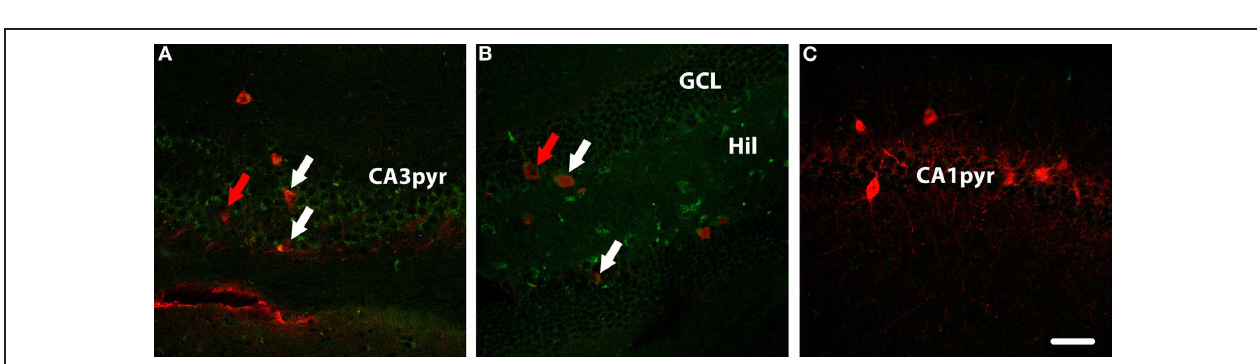
FIGURE 4 | GAD-67 (red) and WGA (green) immunolabelling in ventral dentate gyrus of DBH-WGA (A) and wildtype (B) mice. (A) Co-labelling of GAD67 and WGA is seen among granule cell interneurons (e.g., white